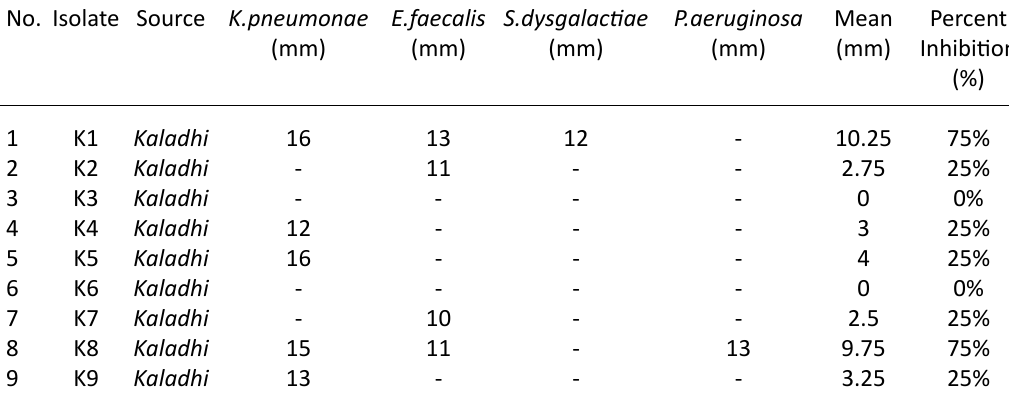
Table 3. Screening of probiotic isolates on the basis of their antagonistic pattern against pathogens by disc diffusion method